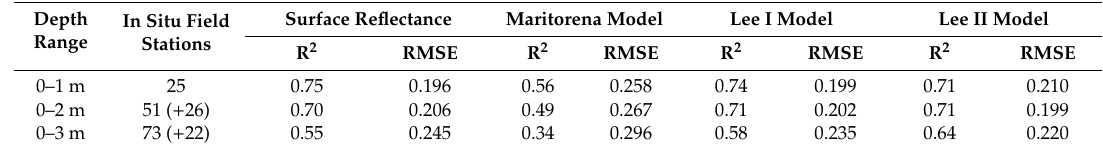
Table 3. The coe ffi cients of determination (R 2 ) and root mean square error (RMSE) between the reflectance at the 570.6 nm and higher plants percent cover for the water surface reflectance and bottom reflectance produced by the Maritorena and Lee water column correction